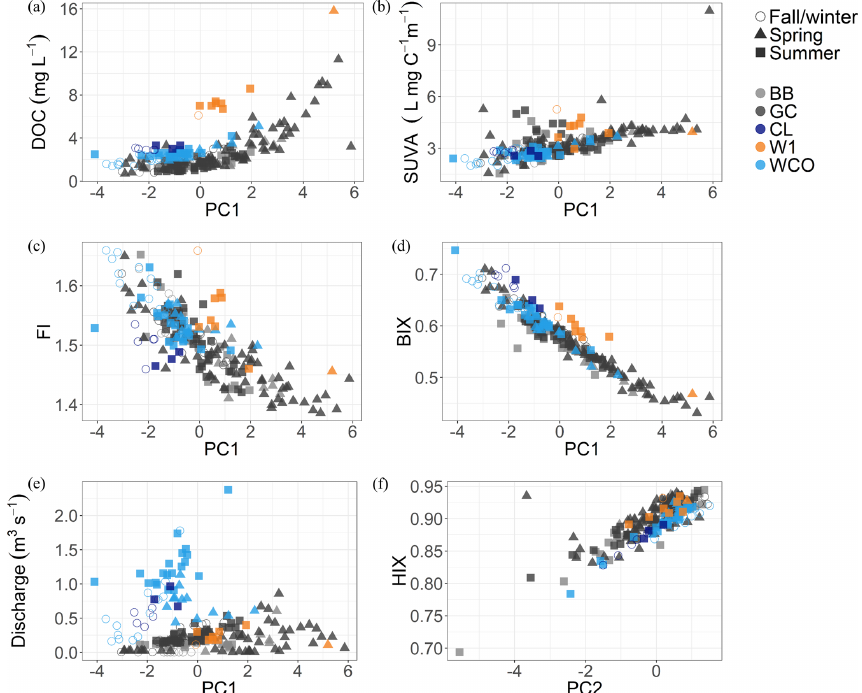
Figure 6. Regressions of principal components to DOC concentrations and DOM indices. Regression of PC1 to DOC concentrations im- plies some non-linear behaviour. Samples are grouped by season: triangles represent spring (15 April–15 June), squares represent summer (16 June–15 August) and circles represent fall/winter (16 August–14 April). Samples are also grouped by landscape type: bright blue refers to mesoscale outlet (WCO), dark blue represents lake (CL), orange represents Wetland 1 (W1) and grey represents headwaters (light grey – BB and dark grey – GC).